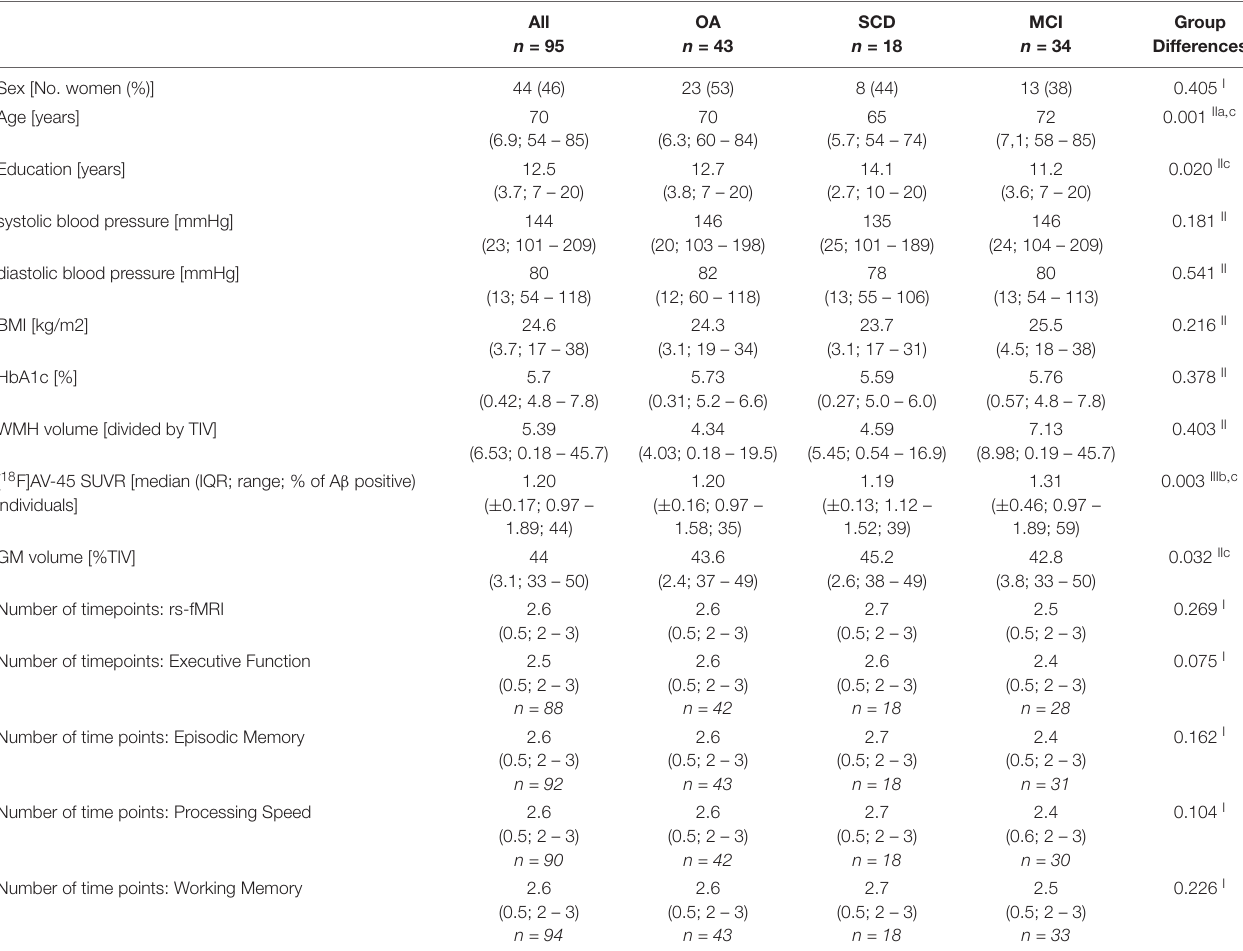
TABLE 1 | Sample characteristics at